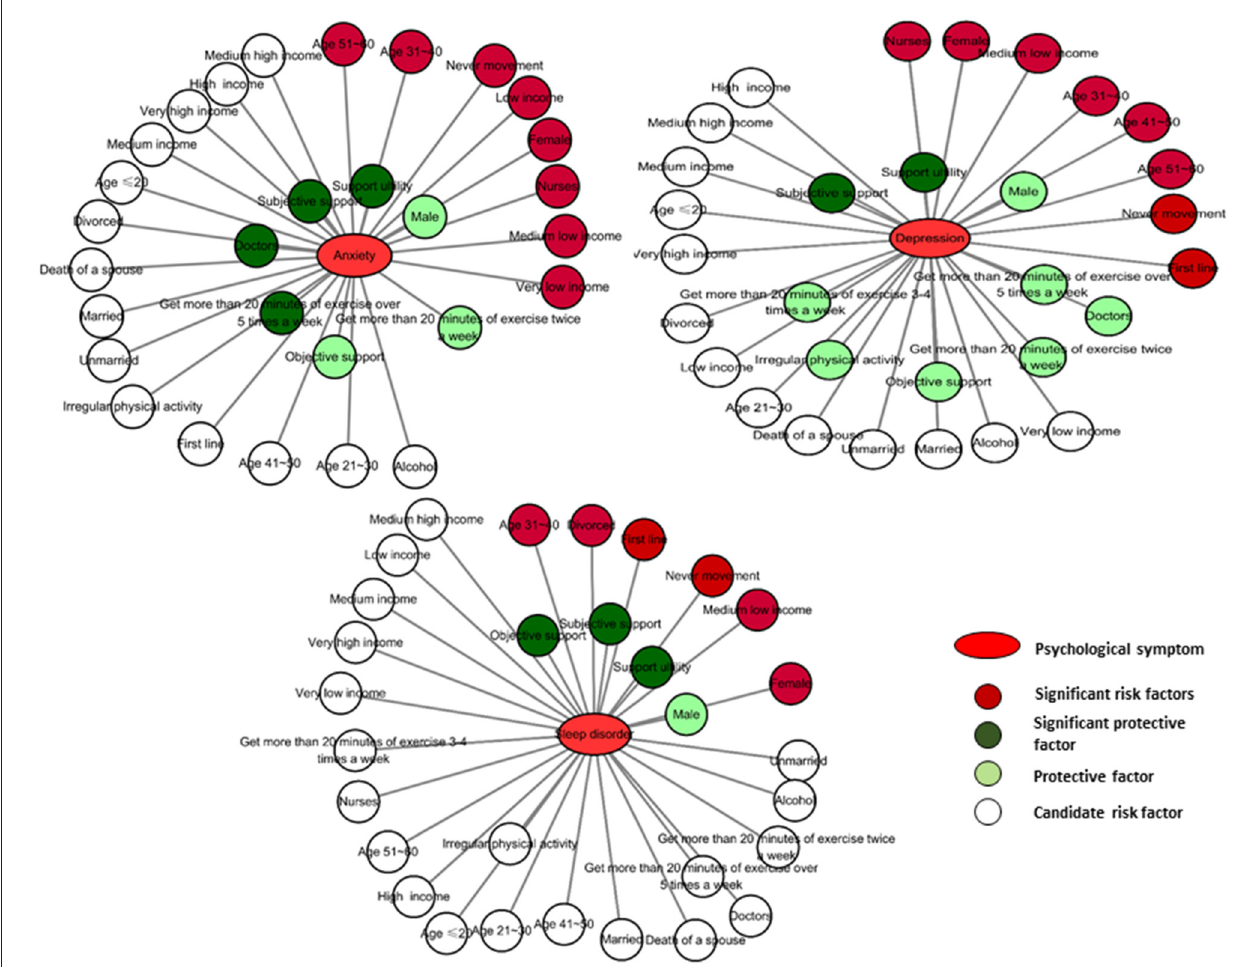
FIGURE 4 | Roadmap of risk factors and protective elements for psychological symptoms of medical staff during COVID-19